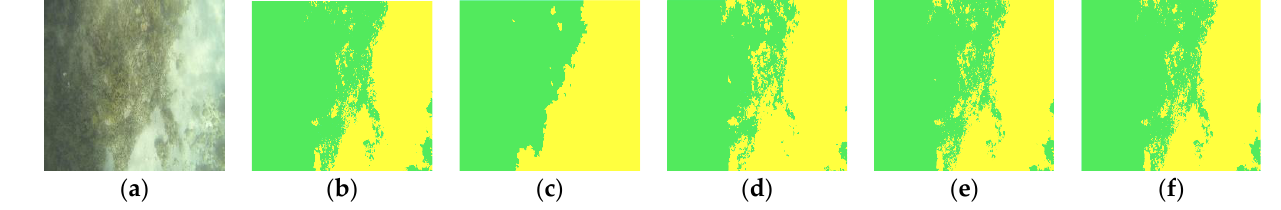
Figure 4. The results of evaluating the tested segmentation algorithms using low illuminated and high contrast algae images. Images (1 – 7) had two categories, and (8 – 14) had three categories: ( a ) F1-score; ( b ) IOU.